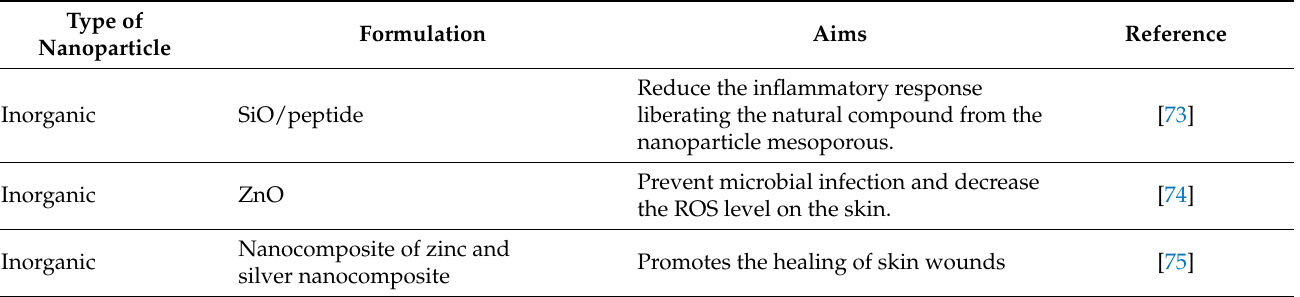
Table 1. Applications of different types of nanoparticles for pathophysiological skin conditions based on dermis